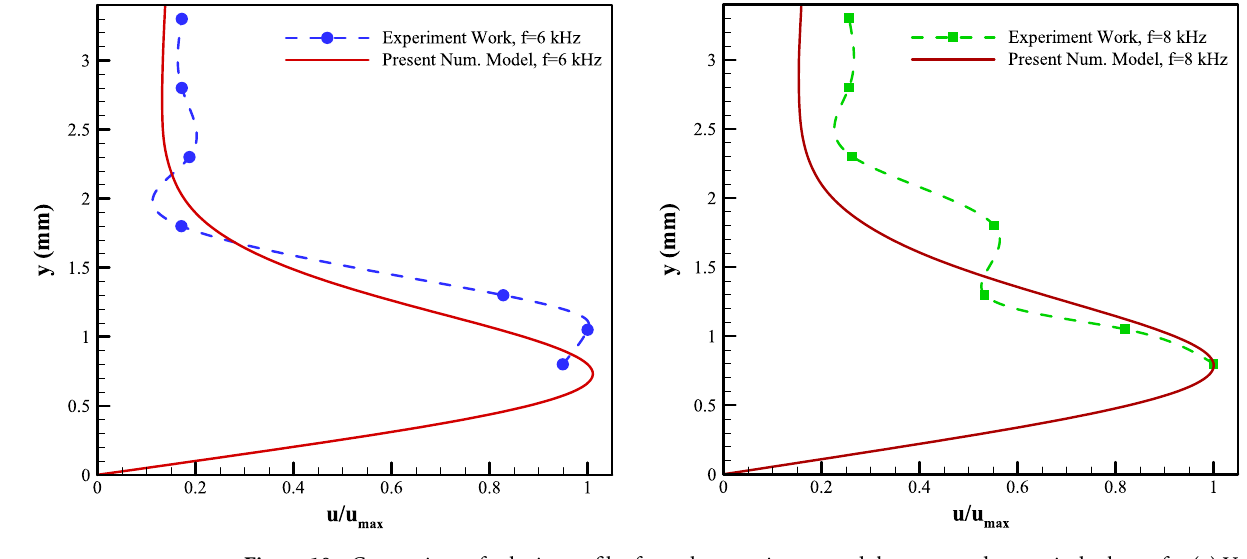
Figure 10. Comparison of velocity profiles from the experiments and the presented numerical scheme for ( a ) V = 7.2 kVpp, f = 6 kHz, and ( b ) V = 7.2 kVpp, f = 8 kHz, at 5 mm downstream of the exposed electrode’s leading edge.